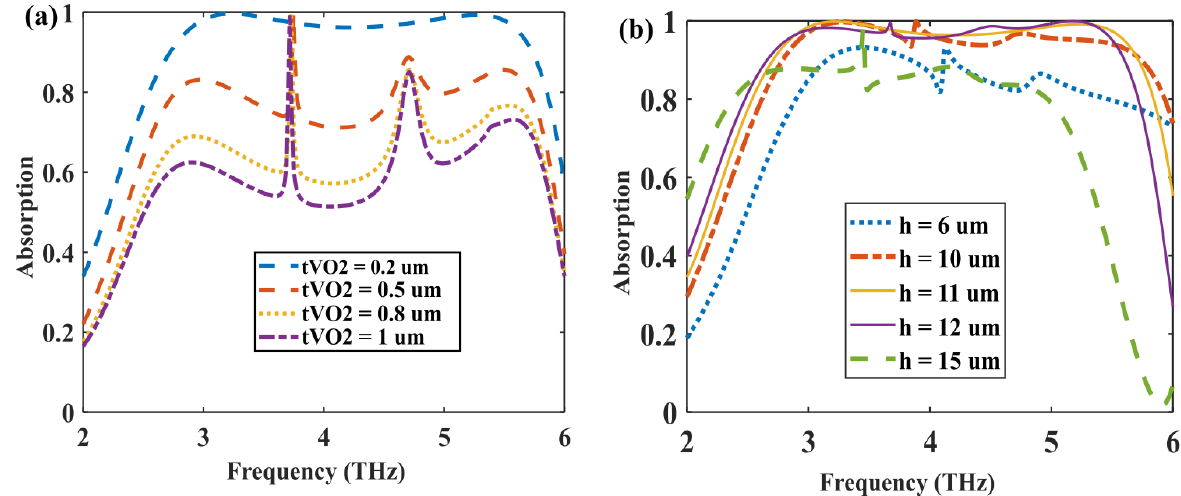
Figure 12. The influence of the ( a ) thickness of VO 2 and ( b ) thickness of the middle dielectric layer (quartz) on the design absorber absorption.